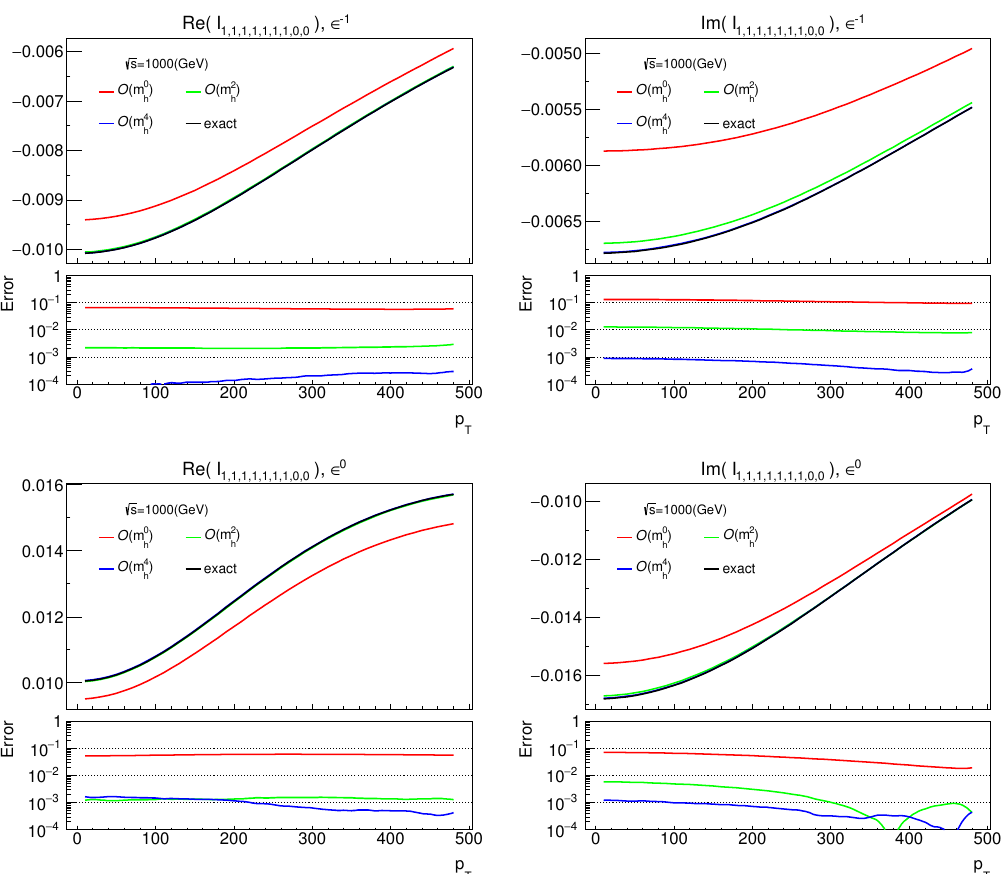
Figure 8 . The real part (left two plots) and the imaginary part (right two plots) of the order (cid:15) (cid:0) 1 and (cid:15) 0 coe(cid:14)cient of the two-loop integral I 1 ; 1 ; 1 ; 1 ; 1 ; 1 ; 1 ; 0 ; 0 in topology E as a function of the Higgs p boson transverse momentum p T with s = 1000 GeV. The integral has been multiplied by m 6 make it